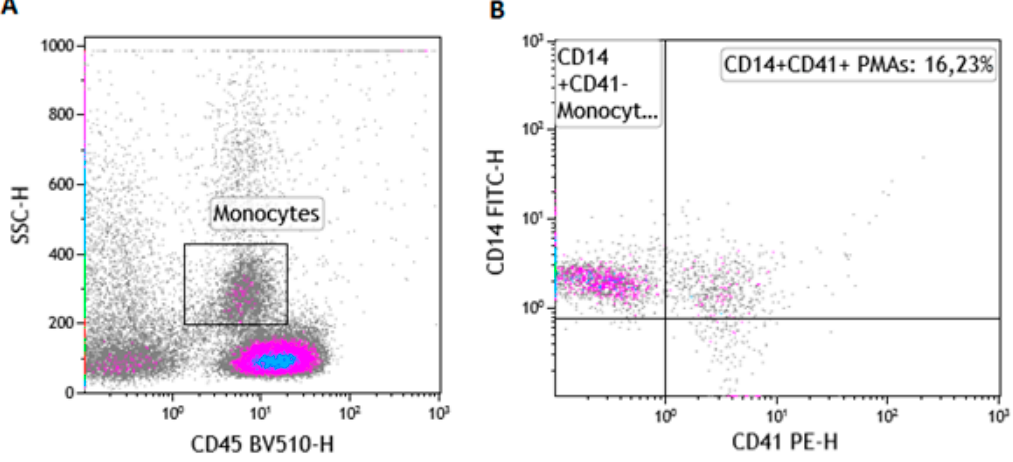
Figure 1. Gating strategy for the enumeration of platelet monocyte aggregates (PMAs). ( A ) illustrates the use of the pan leucocyte marker (CD45) and the side scatter (SSC) properties to identify the monocyte population in whole blood using a control sample. ( B ) illustrates the enumeration of platelet monocyte aggregates (CD45+CD14+CD41+).